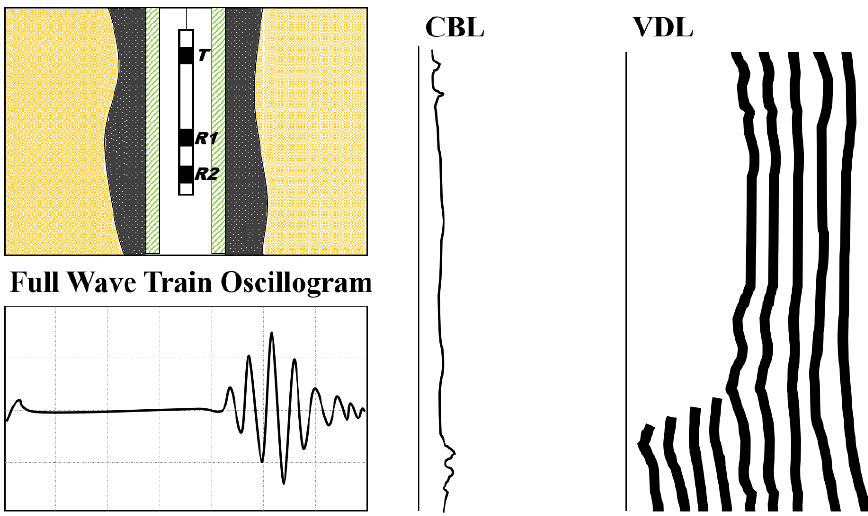
Figure 4. Waveform and CBL-VDL under good cementation of the first and second interface. (3) Good cementation at the first interface, poor cementation at the second interface.